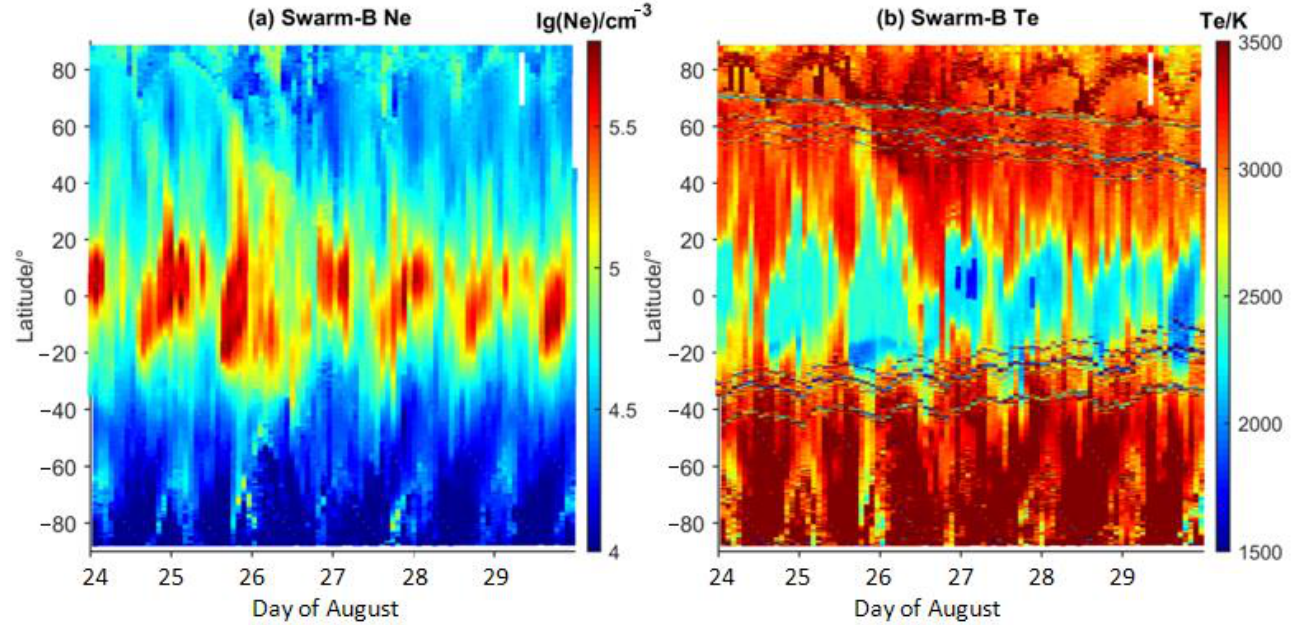
Figure 7. The electron density ( a ) and electron temperature ( b ) from Swarm-B in local daytime during 24 to 29 August in 2018.